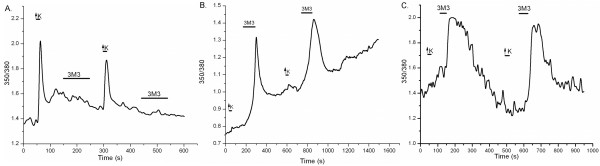
A depolarizing stimulus of high K+ solution does not increase [Ca2+]i in bitter, sweet, and umami sensitive cells. Panel A shows an isolated non-GFP cell from a T1R3-GFP expressing animal. Some non-GFP cells do present an increase in [Ca2+]i when challenged with high K+ solution. Cells that have [Ca2+]i responses to high K+ do not respond to the PLC agonist m-3M3FBS, 10 μM. T1R3-GFP expressing cells in Panel B do not show changes in [Ca2+]i to bath applied high K+ but do show reversible increases in [Ca2+]i to bath applied PLC agonist m-3M3FBS (10 μM). TRPM5-GFP expressing cells in Panel C do not change [Ca2+]i to high K+ but show reversible increases in [Ca2+]i when 10 μM m-3M3FBS is present.